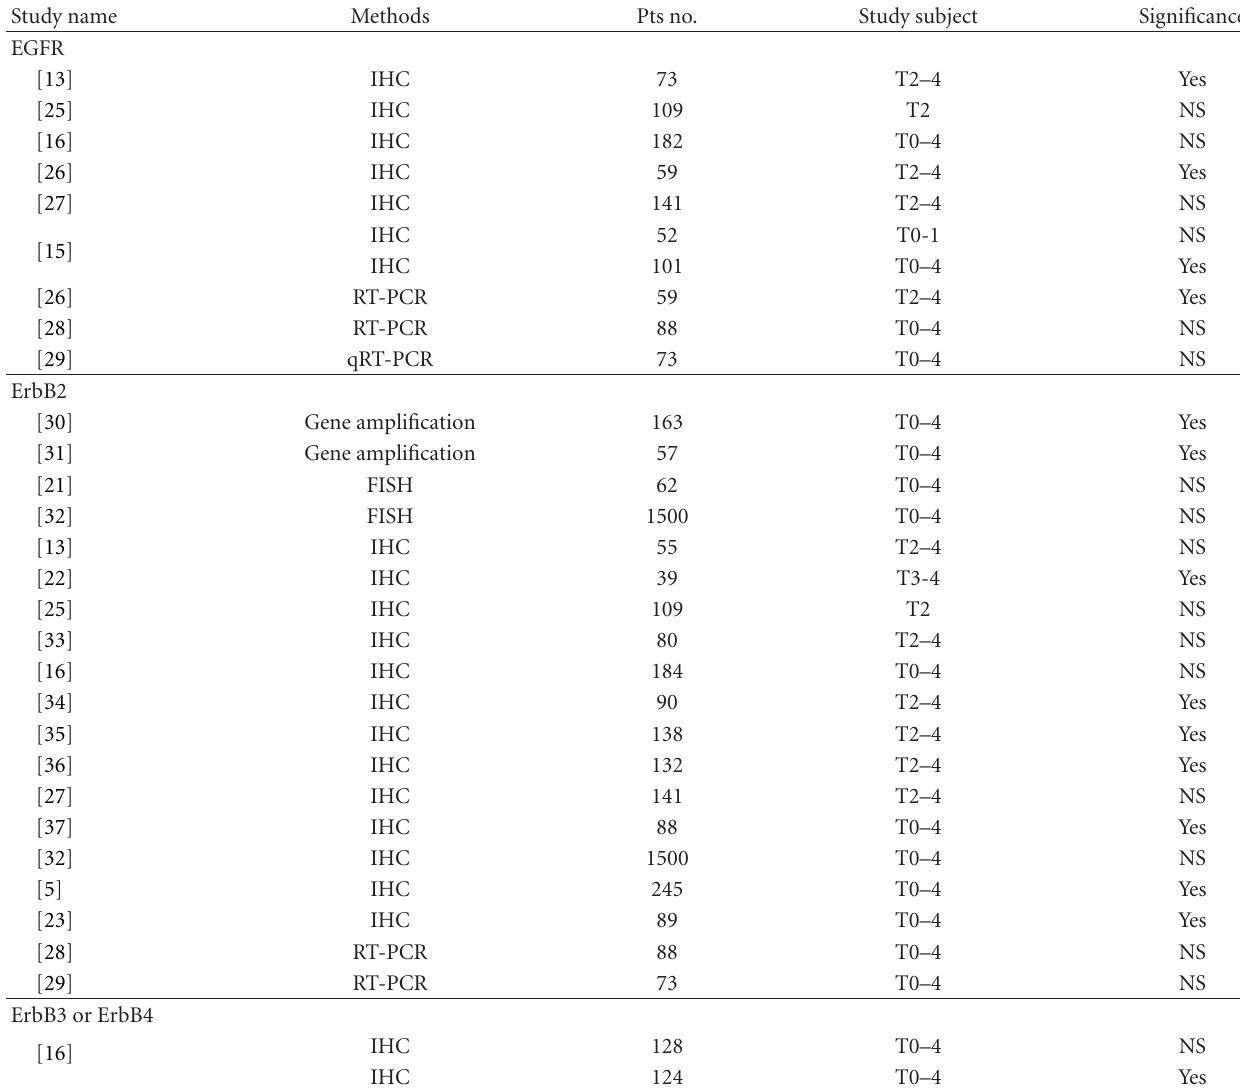
Table 3: Significance of ErbB receptor family as a marker for bladder cancer